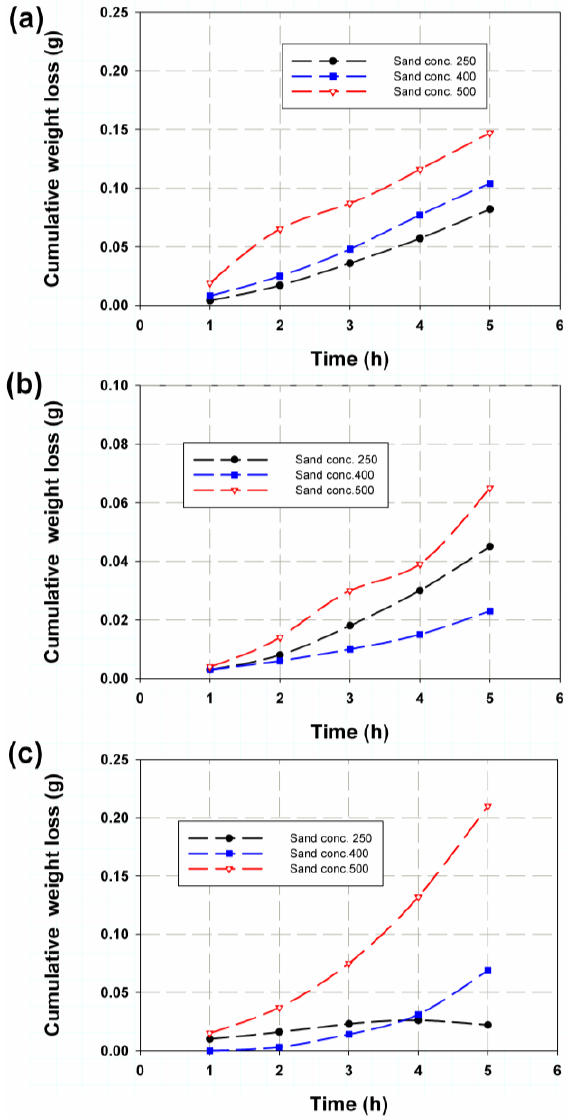
Figure 3. Cumulative weight loss versus time for ( a ) 0.01 m 3 /min, ( b ) 0.0067 m 3 /min and ( c ) 0.01 m 3 /min and 10 wt.% Cl flow rates.